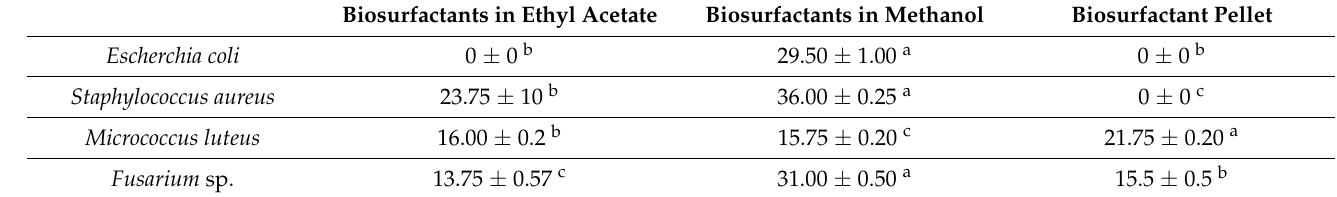
Table 4. The antimicrobial activity of the biosurfactant pellet and the biosurfactants dissolved in ethyl acetate or methanol. Values expressed in mm present the diameter of the zone of inhibition as detected in the agar well diffusion test. Values are the average from triplicate experiments. Different subscript letters on the same line show significant difference at p < 0.05.